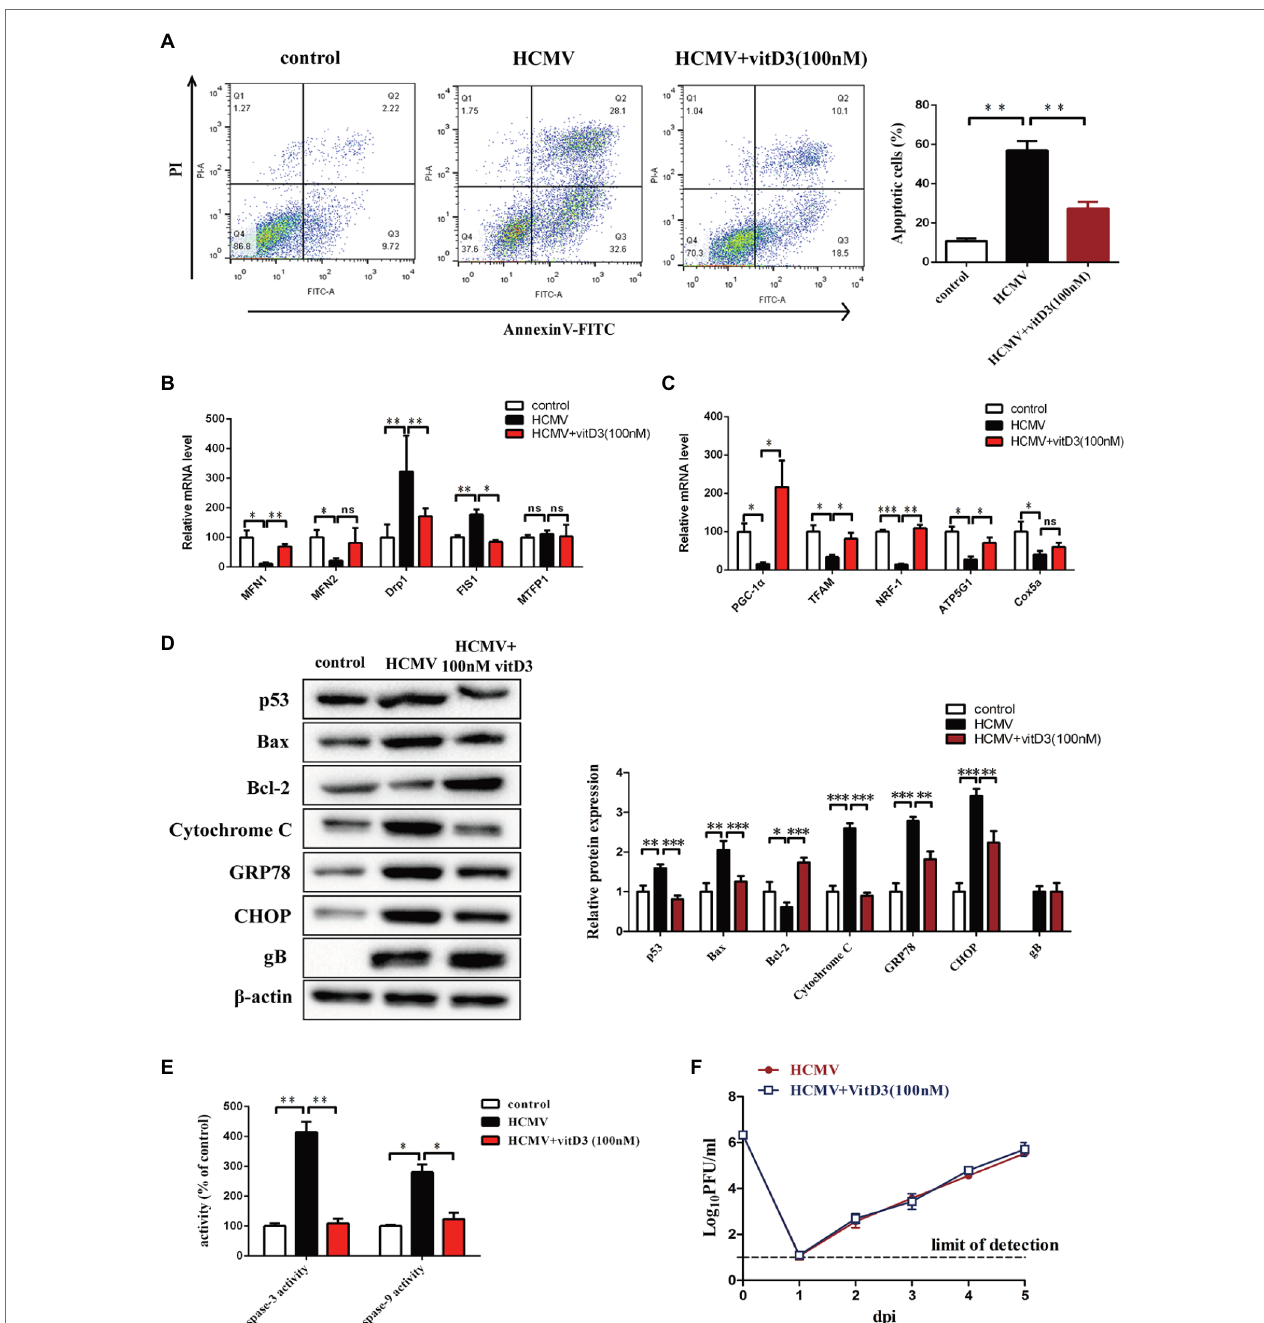
FIGURE 1 | The role of vitD3 on human cytomegalovirus (HCMV)-induced apoptosis of human aortic endothelial cells (HAECs). HAECs were mock-infected (control) or infected with VHL/E strain of HCMV [multiplicity of infection (MOI) = 5] for 4 days. In the vitD3-treated group, HAECs were continuously added with 100 nM vitD3 from the second to the fourth day of HCMV infection. After 4 days, HAECs were harvested for the following experiments. (A) Detection of cellular apoptosis in different groups by flow cytometric assay with Annexin-V/PI double staining and quantitative analysis. Left, representative images of flow cytometry; right, statistical charts. Apoptotic cells are calculated as the percentage of Annexin-V single-positive plus Annexin-V/PI double-positive cells. (B,C) qPCR analysis of mitochondrial gene expression in the corresponding groups. (D) Representative Western blot immunolabeling of proteins representing apoptosis, using β -actin as the loading control. Left, representative graphs of three independent experiments; right, statistical charts with densitometric analysis. gB, a HCMV gene used to quantify HCMV infection. (E) The caspase-3 and caspase-9 activities were measured by Caspase-3/9 fluorescent Assay kits. (F) Single-cycle viral replication kinetic curves from HAECs infected at an MOI of 5 were plotted by determining the titer in plaque forming unit (PFU) from supernatants collected at the indicated times postinfected. All data are from experiments performed in triplicate and presented as the mean ± standard deviation (SD). Student’s t- test, * p < 0.05, ** p < 0.01, and *** p < 0.001. ns: no significant